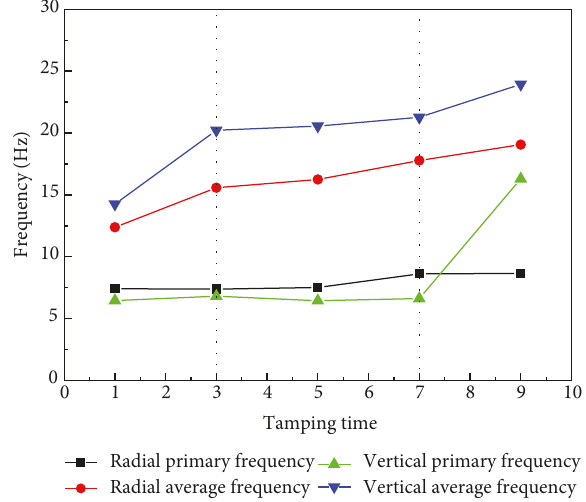
Figure 11: Relations between primary and average frequencies and tamping